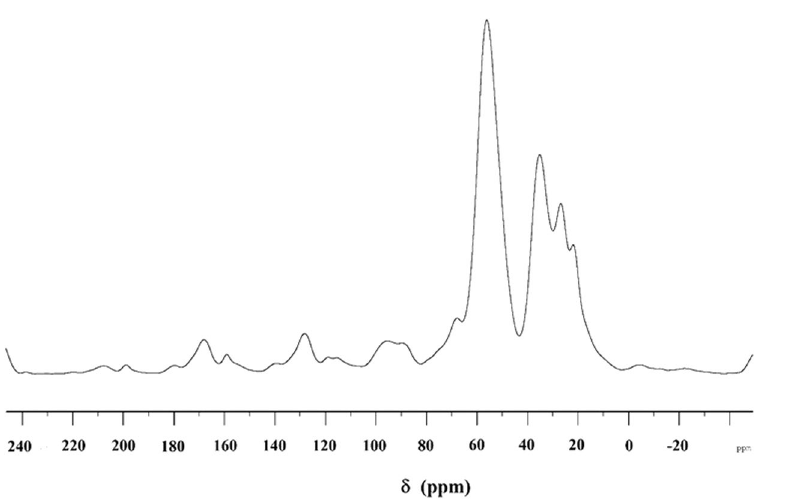
Figure 4. 13 C solid NMR of HCPZA 9